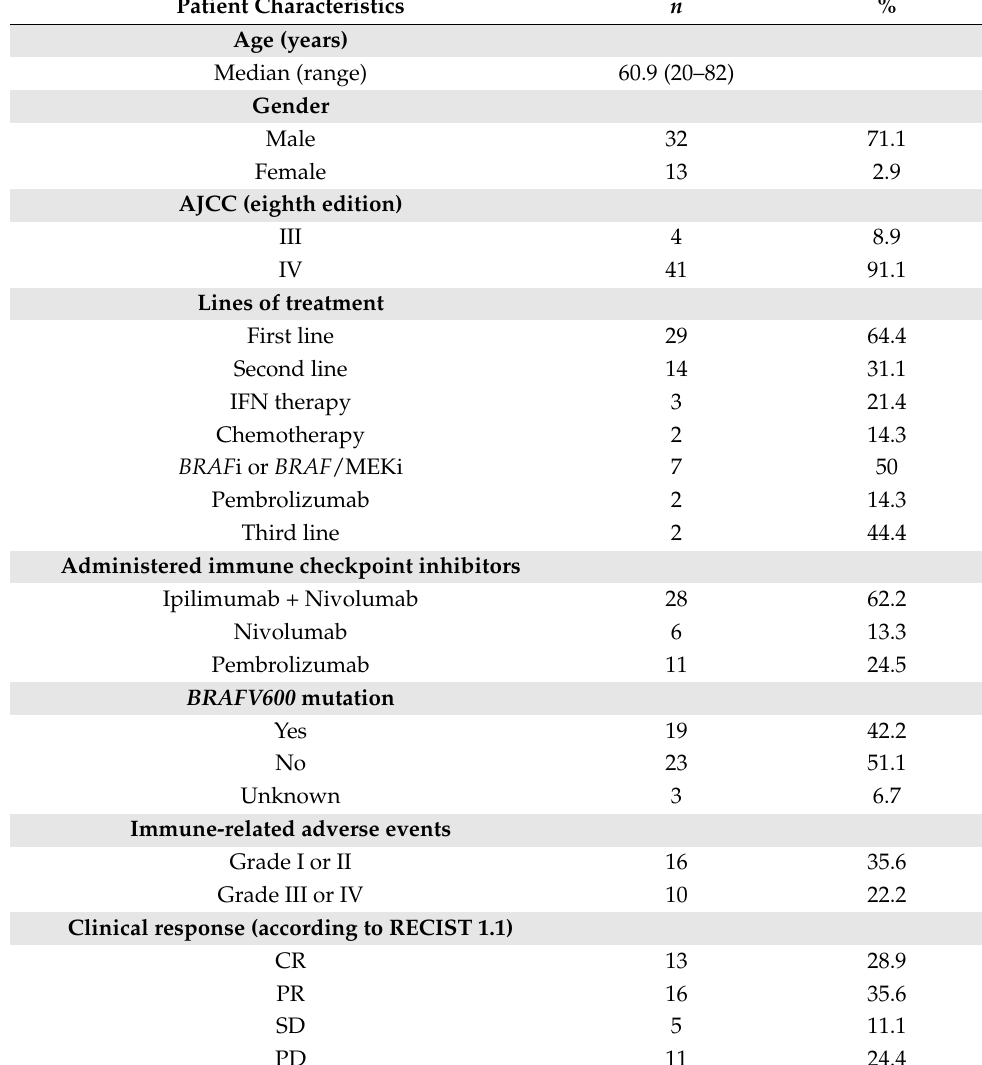
Table 3. Patient description of the 45 included advanced stage melanoma patients for the blood